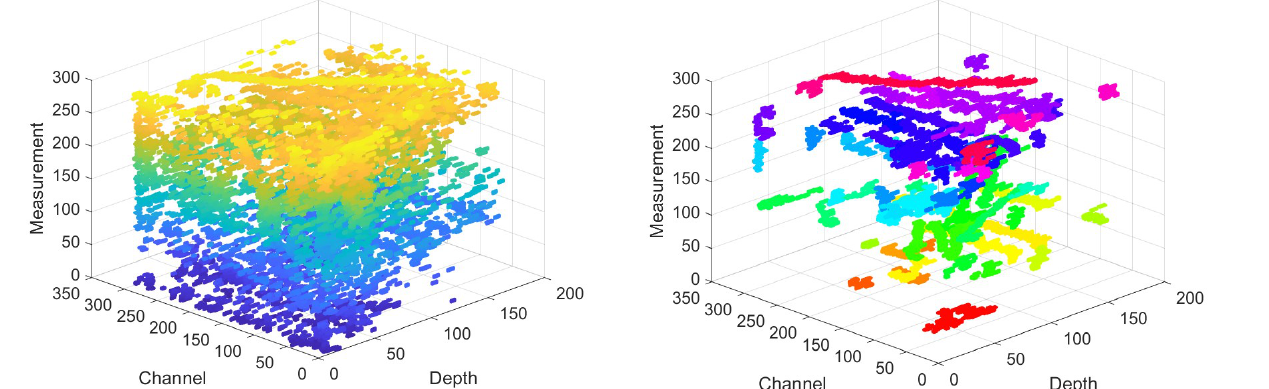
Figure 13 . 3D point cloud with point cloud clusters.